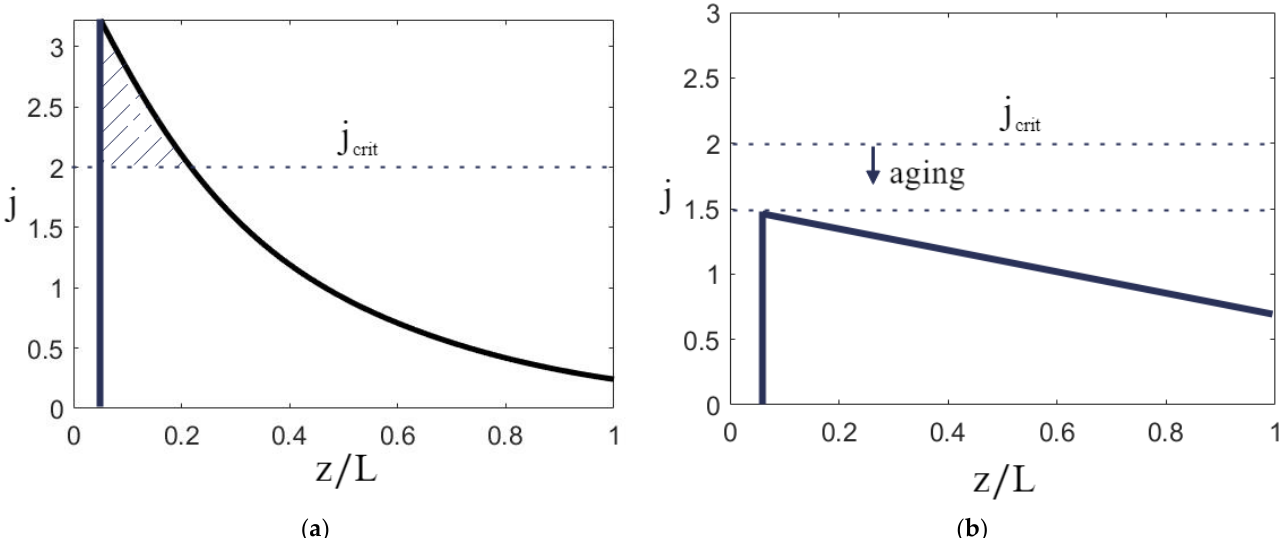
Figure 10. Two different scenarios of PEMFC degradation: ( a ) λ − 1 ≪ 1 ( λ is almost close to one), ( b ) λ − 1 > ~1 ( λ is around two or more).